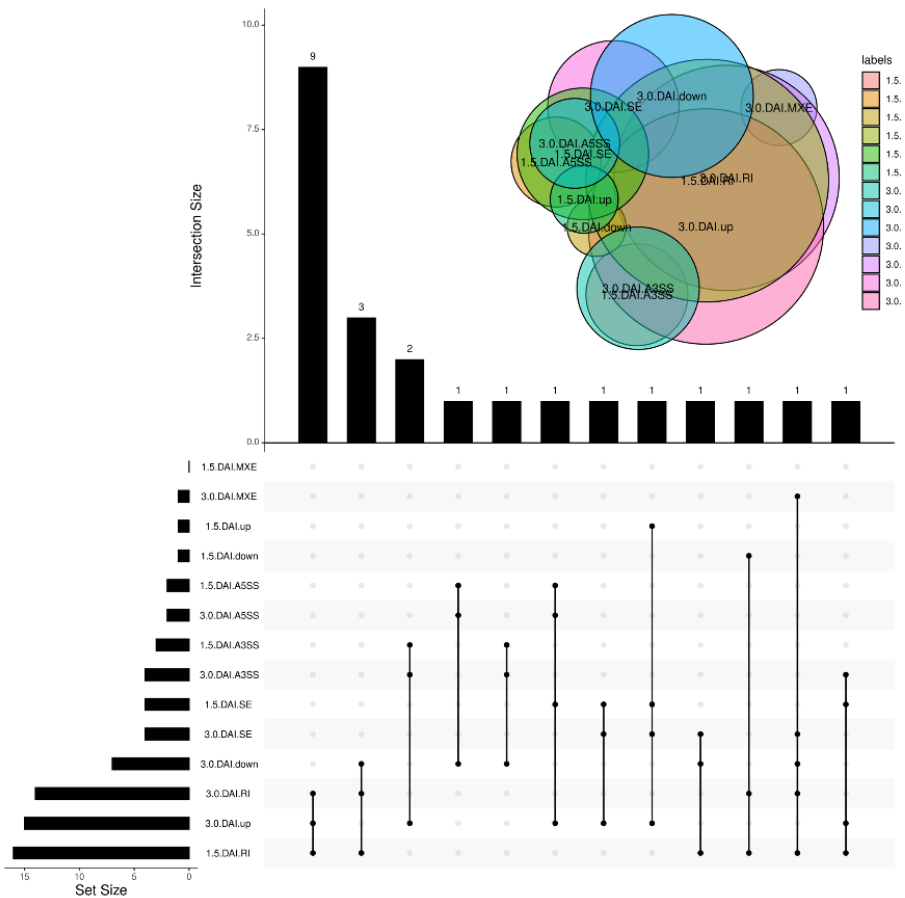
Figure 3. Analysis of differentially spliced genes and differentially expressed genes.